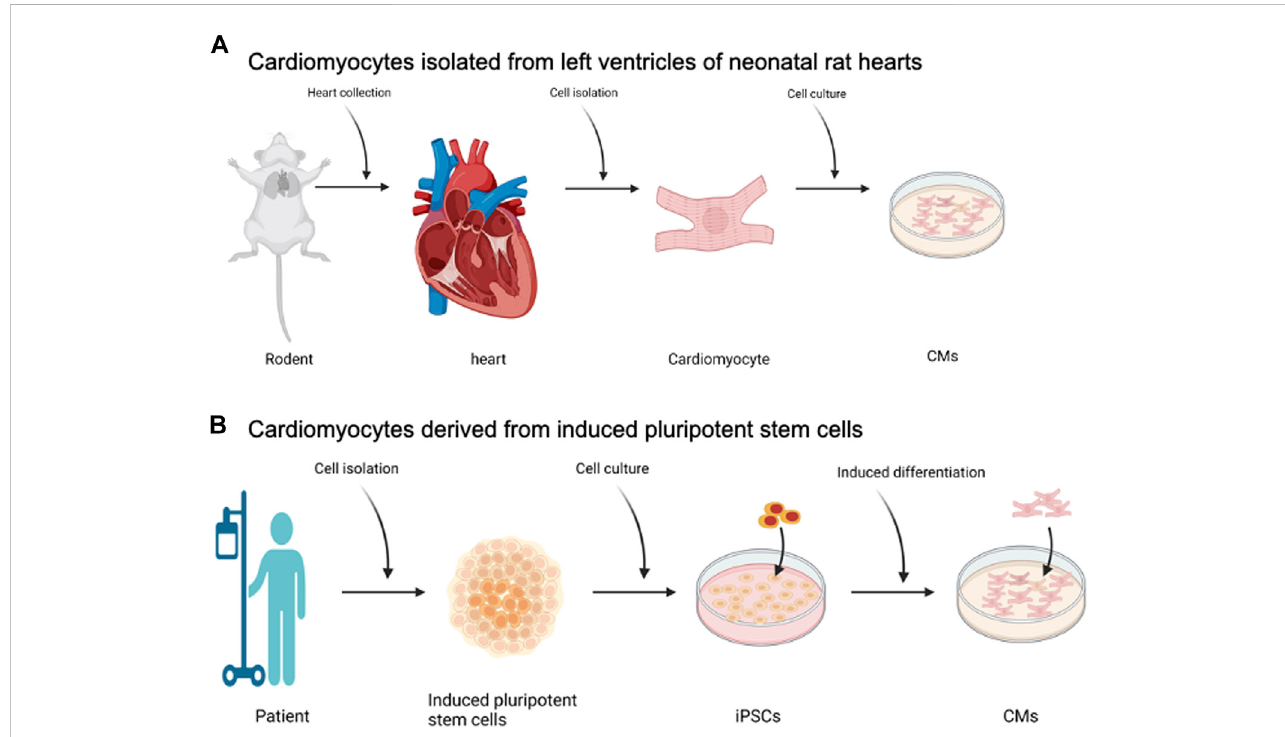
FIGURE 2 Cell Sourcing for Biological Pumps — (A) Cardiomyocytes isolated from left ventricles of neonatal rat hearts, known as NVRMs. (B) Cardiomyocytes derived from induced pluripotent stem cells. Created with